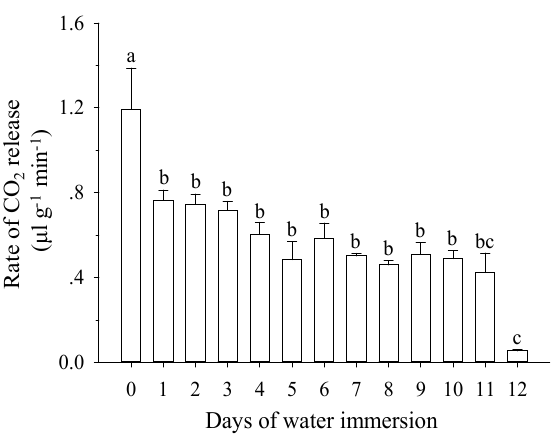
Figure 3. E ff ects of water immersion on larval respiration rates. Means ( ± one SE) among di ff erent days Figure 3. Effects of water immersion on larval respiration rates. Means (± one SE) among different of water immersion followed by di ff erent letters di ff er at p < 0.05 (one-way ANOVA, Tukey test). days of water immersion followed by different letters differ at p < 0.05 (one-way ANOVA, Tukey test).